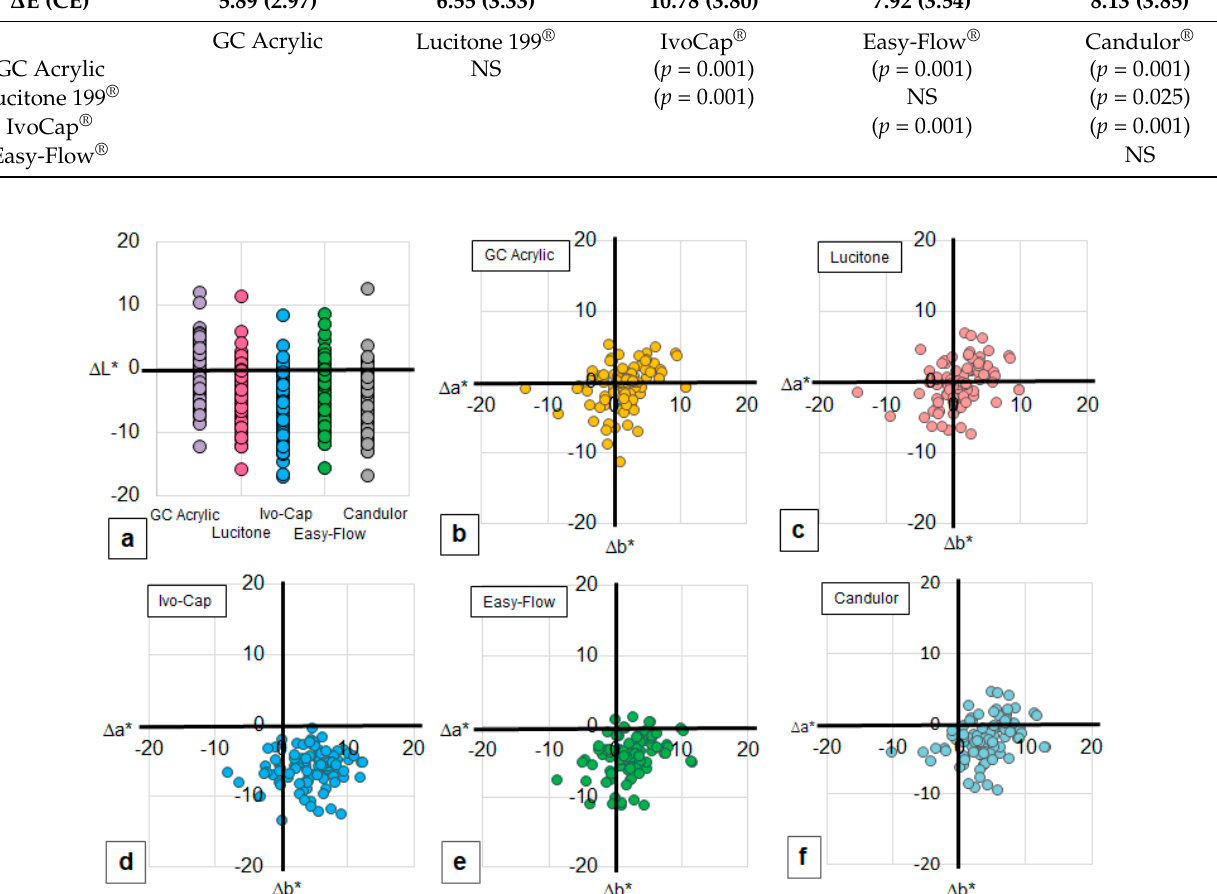
Table 1. Coverage Error (CE) for each shade guide system and gingival color of study participants (Mean and SD). ∆ E (CE)